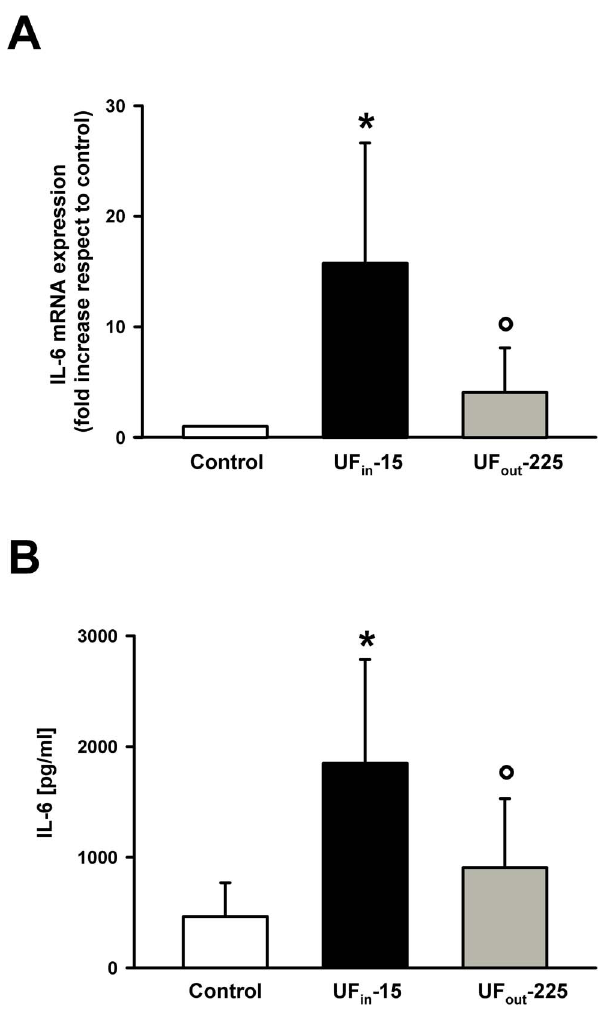
Figure 2. Effect of UF in -15 and UF out -225 on IL-6 gene expression and on IL-6 release in PBMC cultures from healthy subjects. A Mean 6 SD of the fold increase in IL-6 gene expression respect to controls observed in PBMC cultures from 12 healthy volunteers, exposed to UF in -15 (black) and UF out -225 (dark gray). Data were normalized to b -actin mRNA expression and expressed as percent increase respect to those obtained in control cultures, set at 1, in which no UF was added. B, Mean 6 SD of immunoreactive IL-6 concentrations in culture media of PBMCs from twelve healthy volunteers after a 24 h incubation with saline (basal condition, white), UF in -15 (black), or and UF out -225 (dark gray). *p , 0.05vs control; u p , 0.05 vscontrol and UF in - 15, at Kruskal-Wallis one way analysis of variance on ranks followed by Student-Newman-Keuls post hoc test.